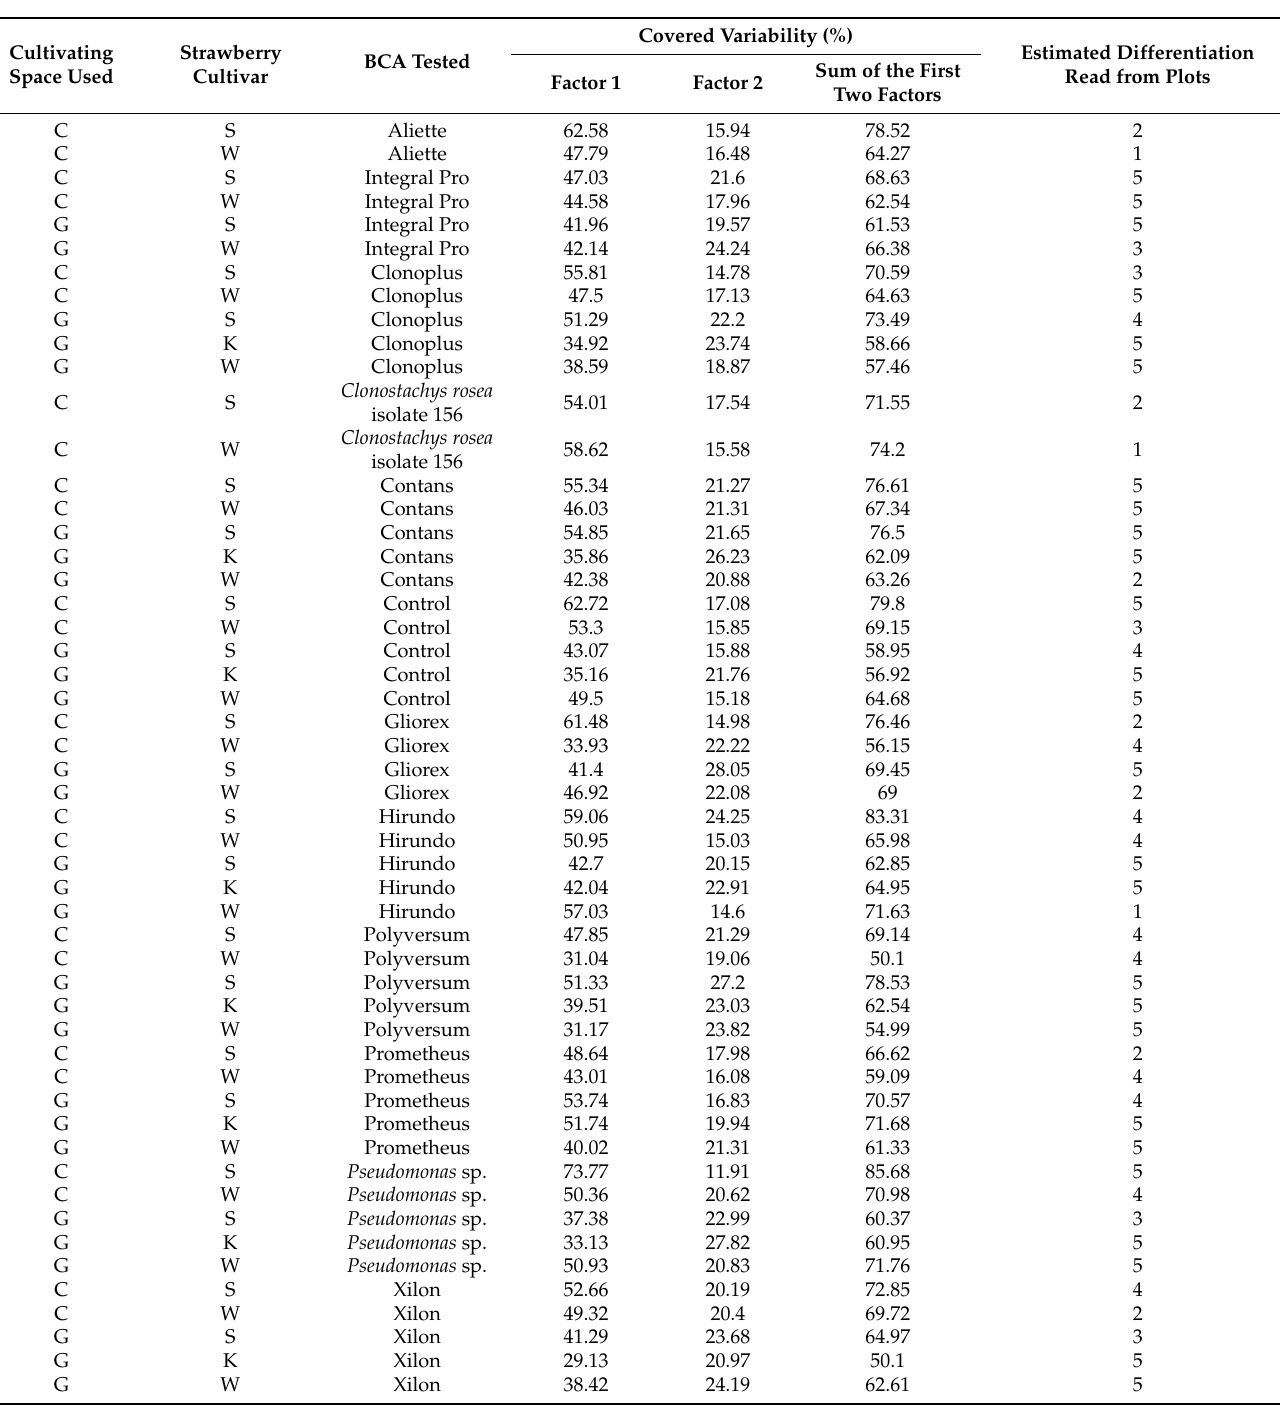
Table 4. The results of evaluation of principal component analysis (PCA)